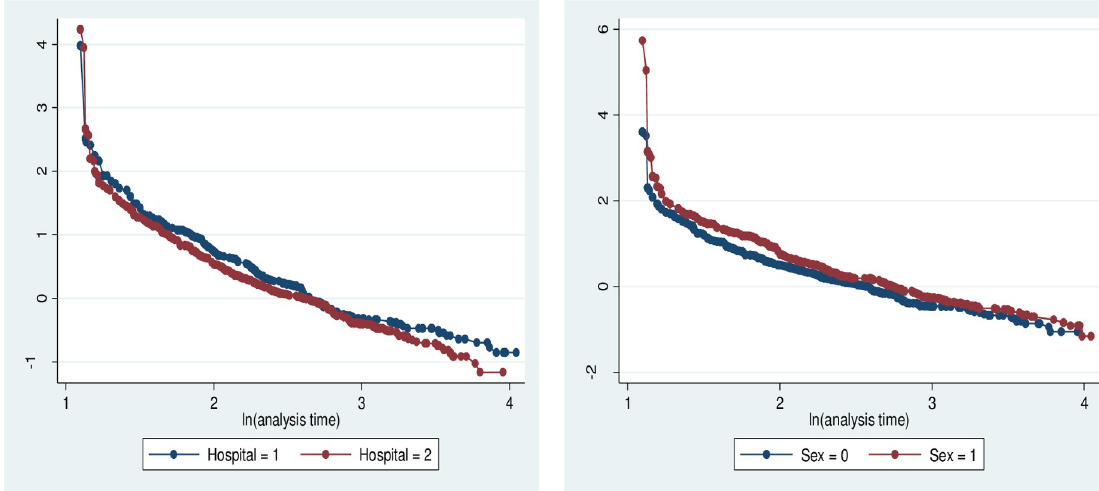
Fig 2. Log minus Log function for hospital and sex, 2018, Addis Ababa.